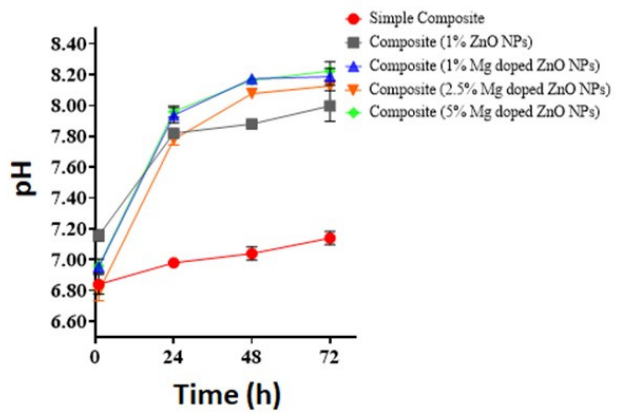
Figure 6. pH buffering effect of composites with bare and Mg-doped ZnO NPs at varying concen- trations.